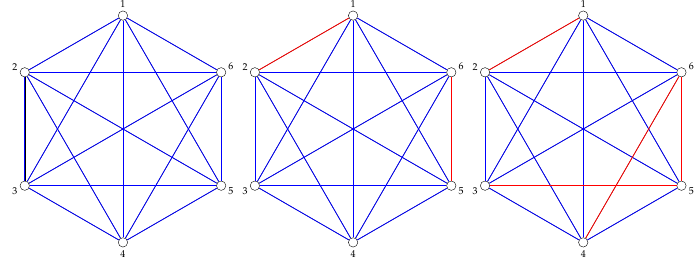
Figure 3. The graphs G ( t = 0 ) , G ( 1 ) , G ( 2 ) ( left ), G ( 3 ) ( center ), and G ( 4 ) ( right ).